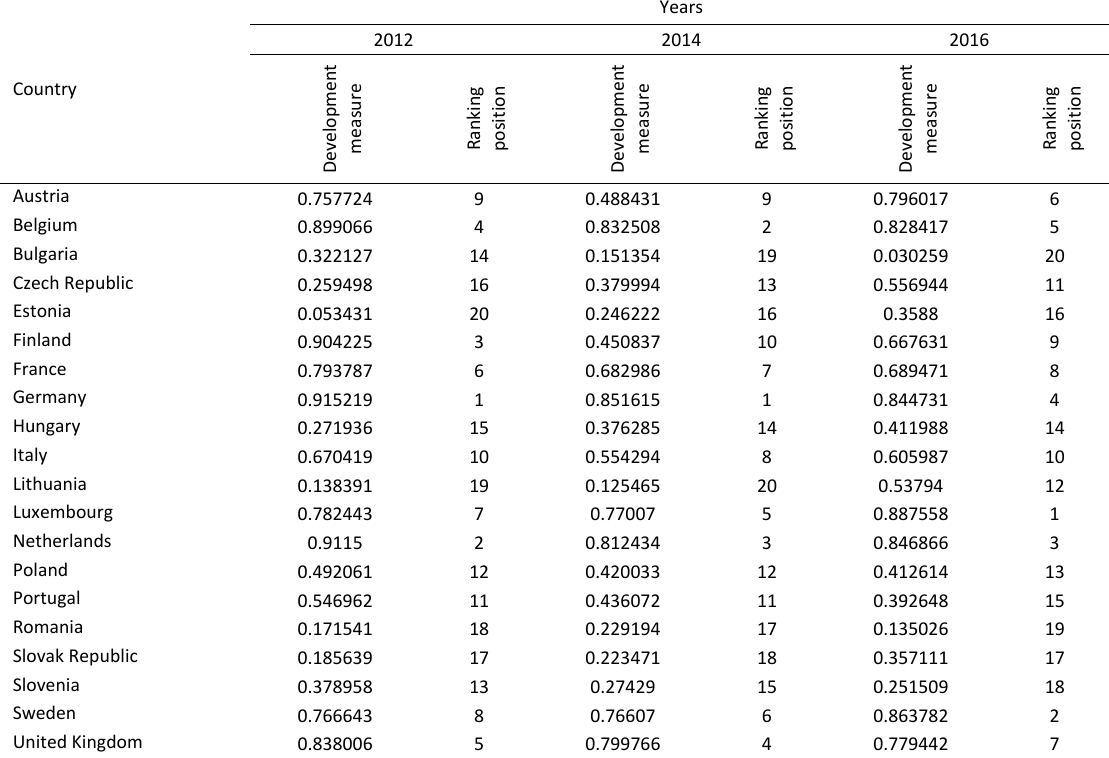
Table 2: Results of linear classification – synthetic measure of development of the logistics performance